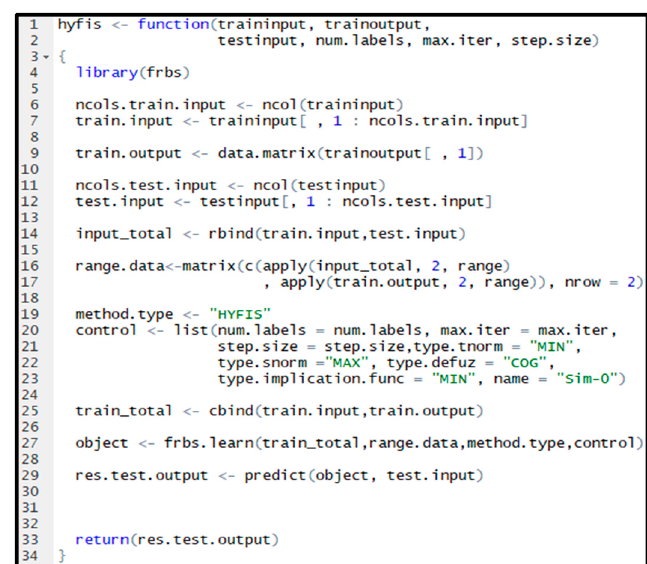
Figure 5. R script of HyFIS forecasting method.